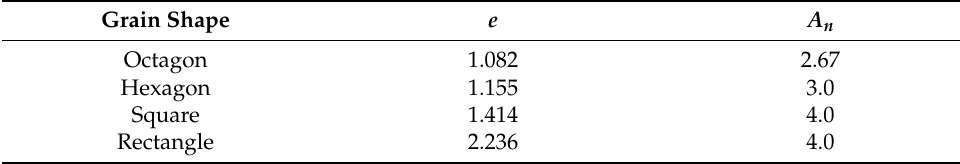
Table 2. Angularity and aspect ratio of the